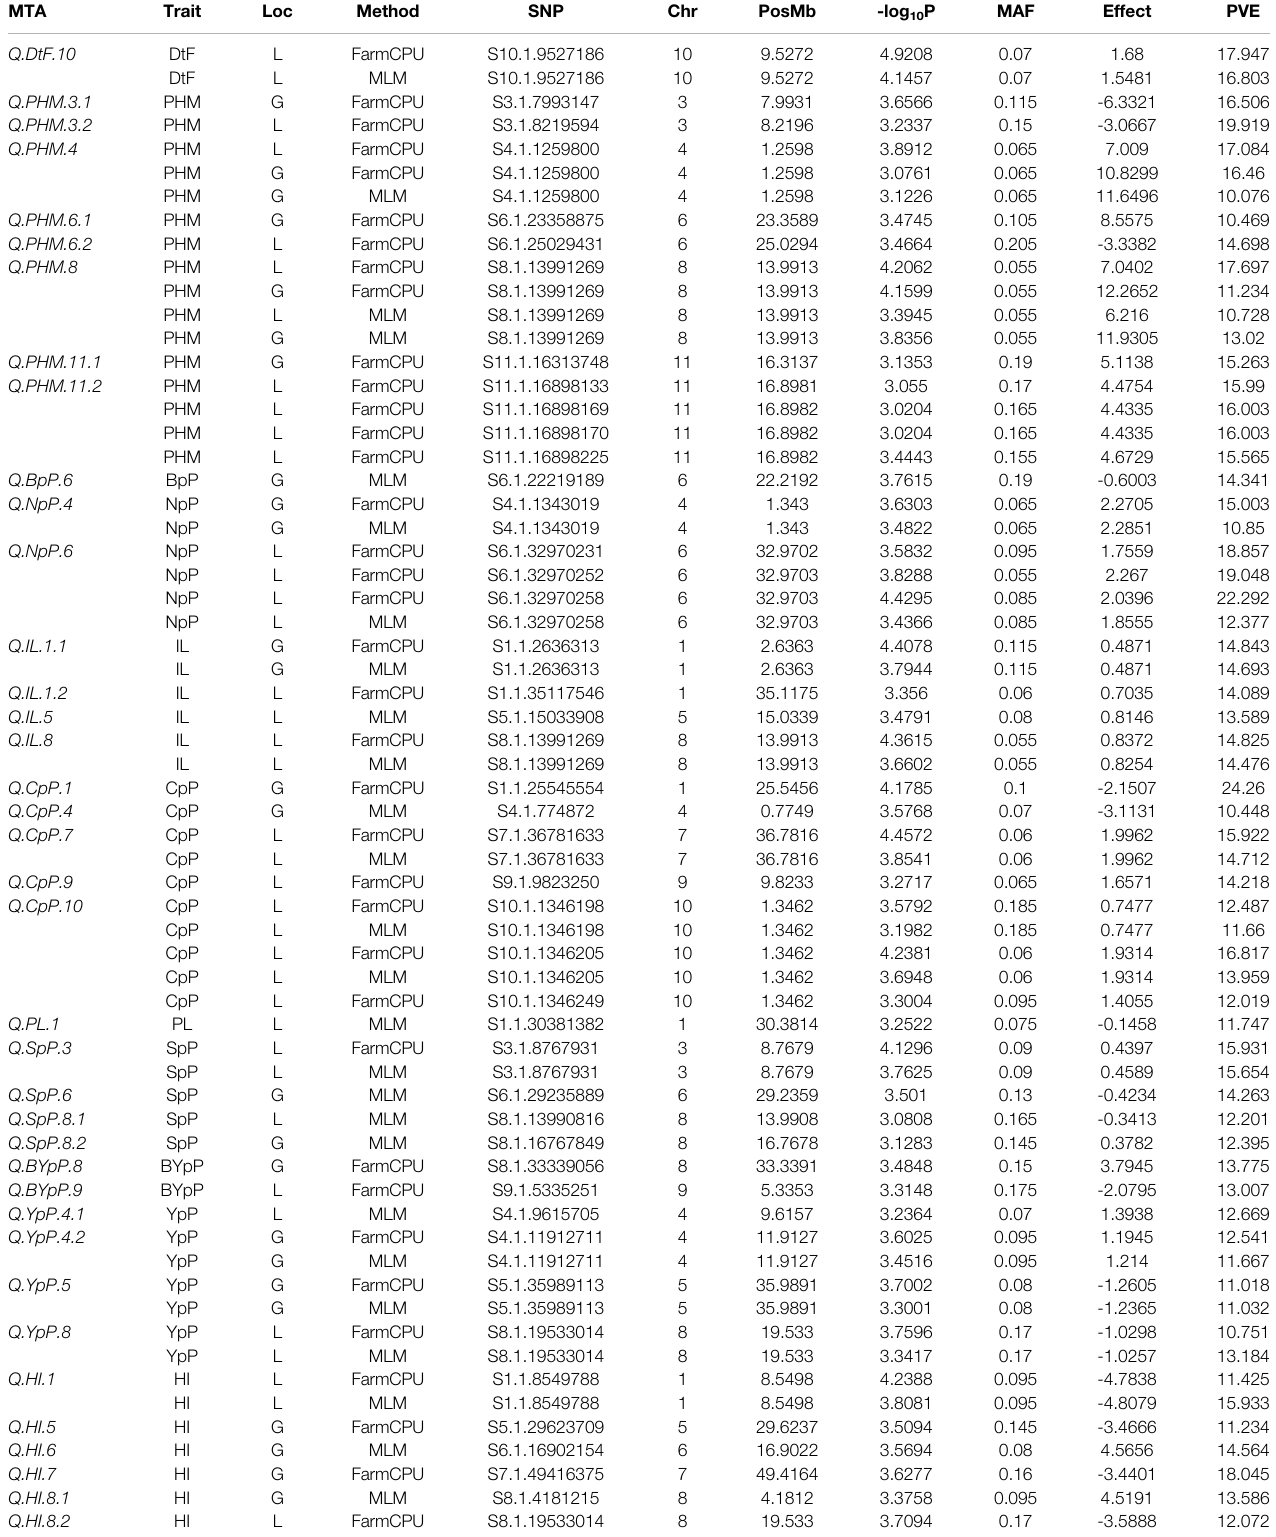
TABLE2| MTAsidenti fi edthroughGenomewideassociationstudyfor100 Vignamungo germplasmlinesinalltheenviornmentsoftwolocationsLudhiana(L)orGurdaspur (G) using FarmCPU and MLM algorithms. MTA